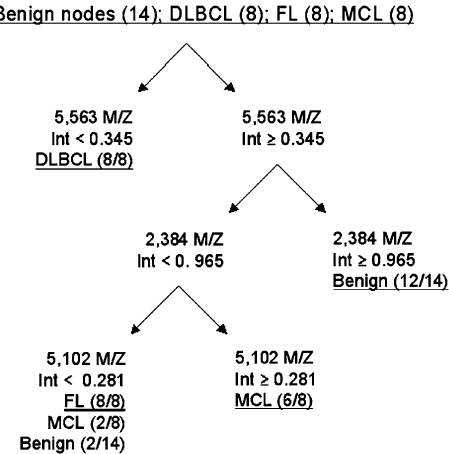
Fig. 4. SELDI-TOF MS based supervised classification algorithm for the classification of DLBCL, FL, MCL and benign lymph nodes. The algorithm is illustrated as a decision-tree with three splits or classi- fier peaks. The classifier peaks are given by their M/Z values in com- bination with the intensity (int) threshold used for classification. The underlined sample group is the one that predominates the resulting group after classification; the number of cases present of each group is indicated between